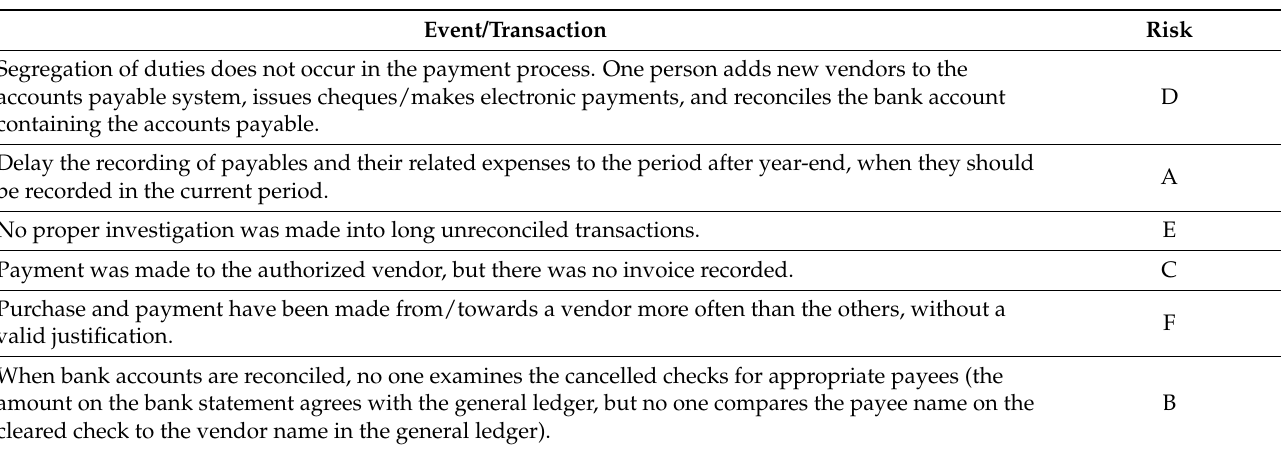
Table 2. Event/Transaction Related to Fraud Risk.